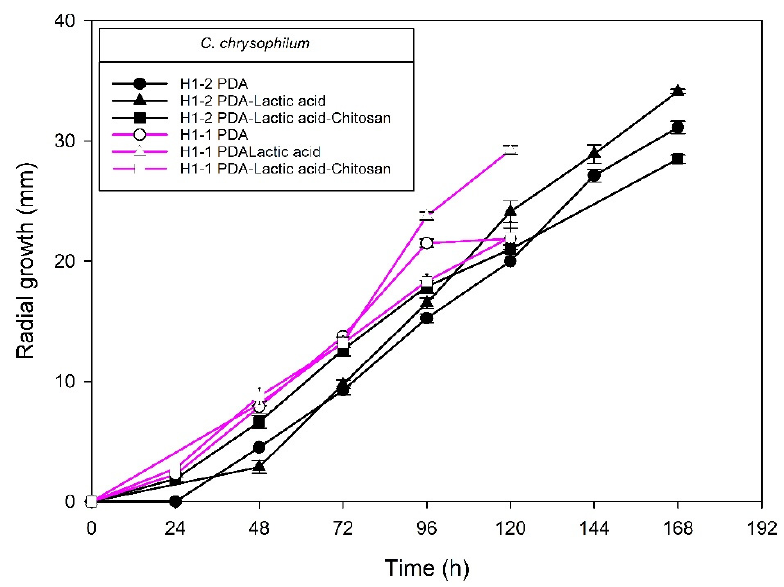
Figure 6. Colletotrichum chrysophilum isolates from anthracnose of mango (H1-2 and H1-1). Kinetics of radial growth (mm) in medium PDA, PDA-lactic acid (0.05 M), and PDA-lactic acid (0.05 M) with 1 g L − 1 chitosan at 25 °C.